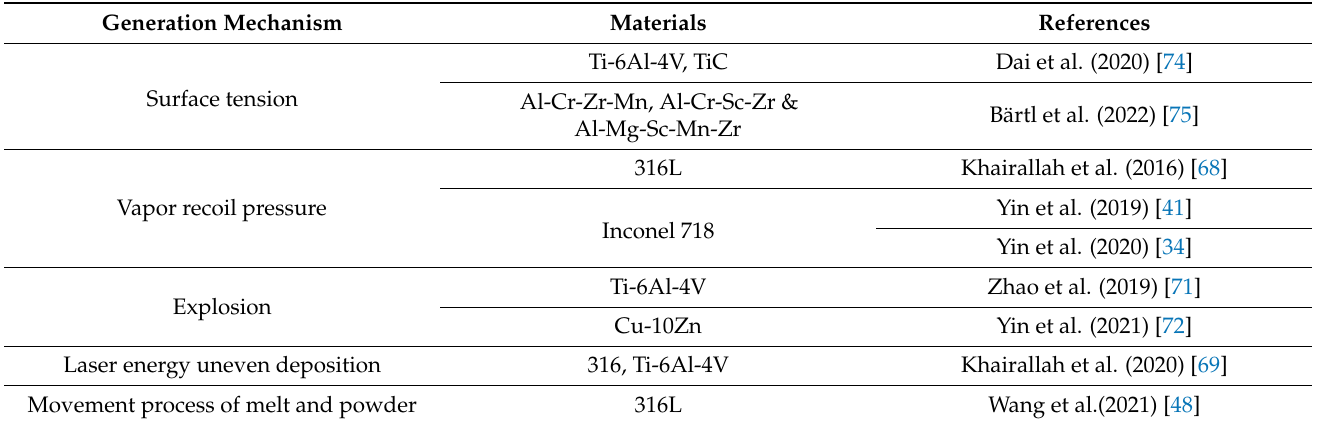
Table 4. Summary of research on droplet spatter ejected from the “liquid base” of the melt pool.